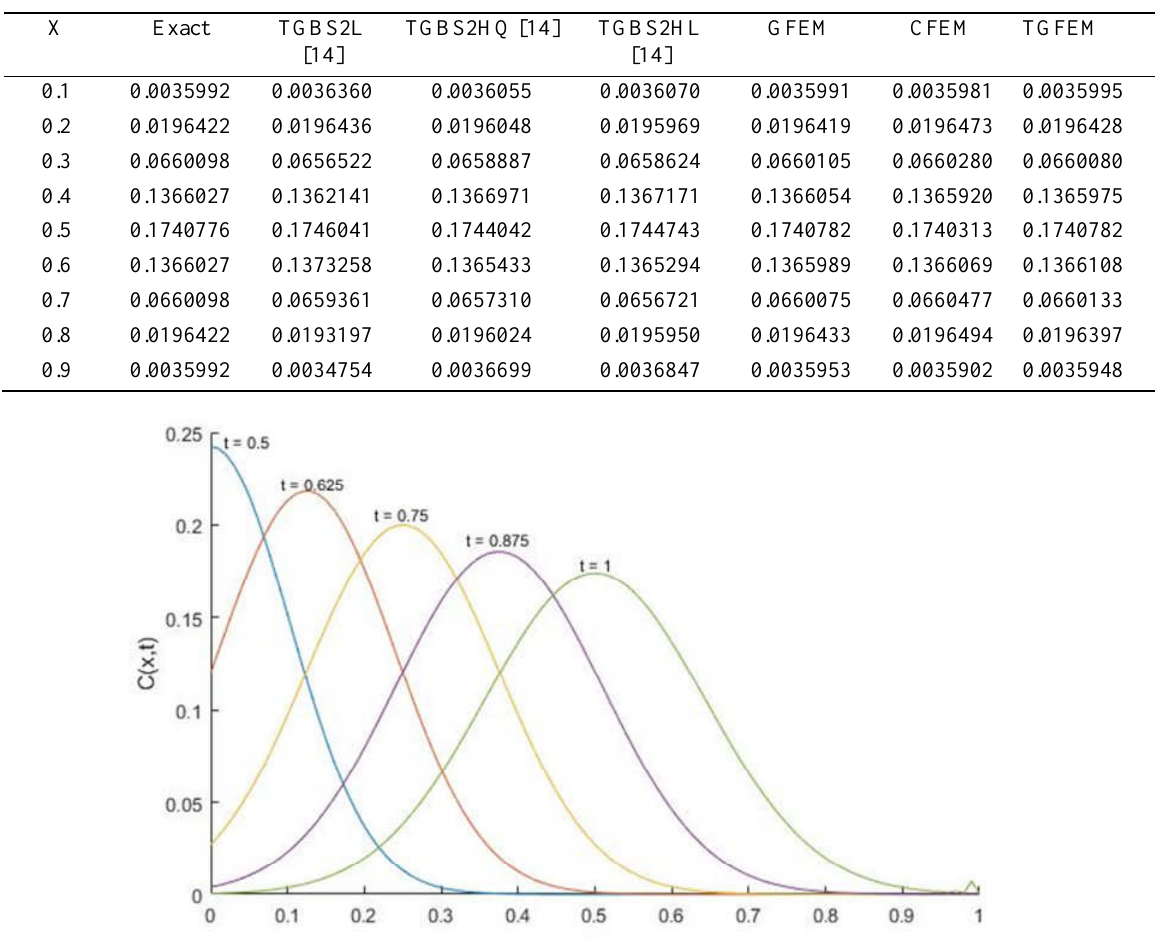
Table 5 . A comparison of present solutions with the literature [14] and exact solution at various nodal points and at (cid:14) (cid:2) 1 in Problem 3.